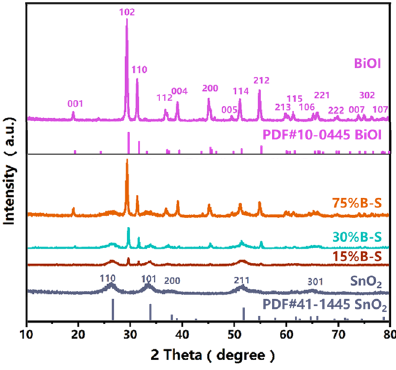
Figure 3. XRD patterns of BiOI, SnO 2 , and X %B-S (where X = 15, 30, and 75).